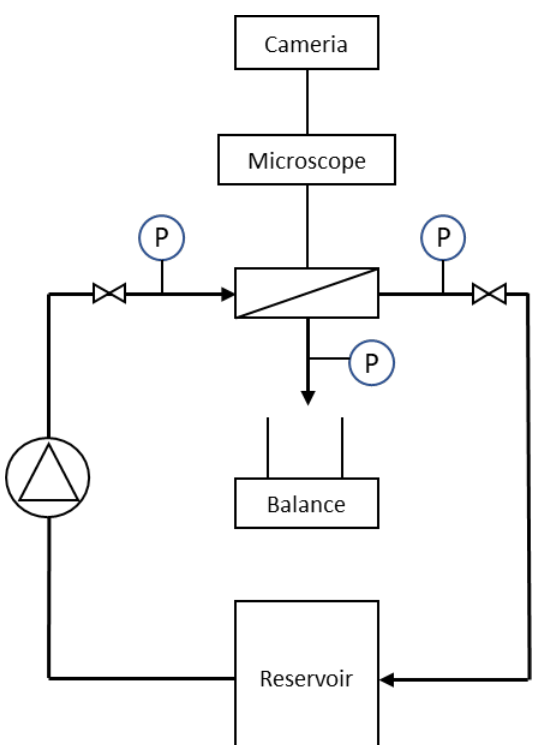
Figure 1. Schematic drawing of filtration system with camera and microscope connected to filtration cell and balance for collection of permeate.